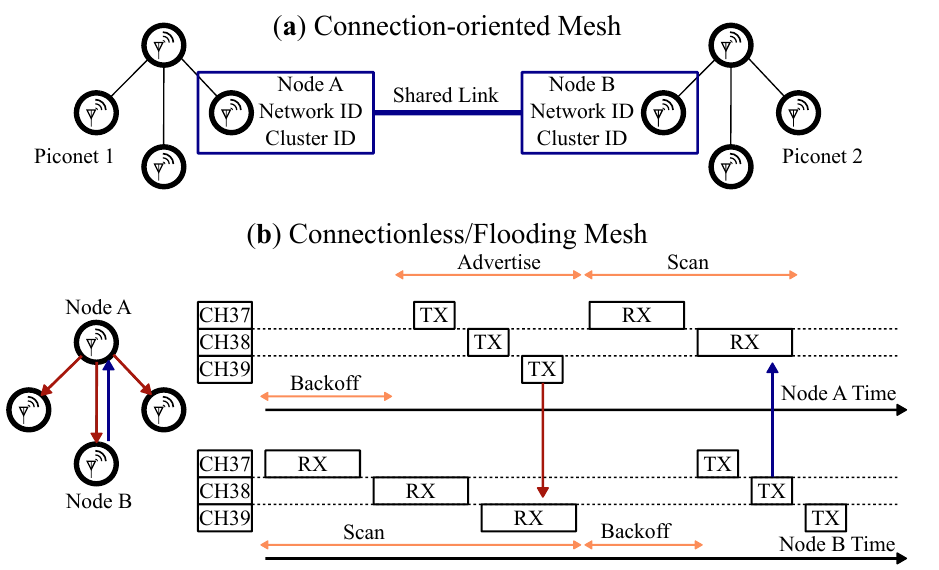
Figure 4. Conceptual representation of the two types of BLE mesh topologies. ( a ) Connection-oriented mesh network. ( b ) Connectionless or flooding mesh